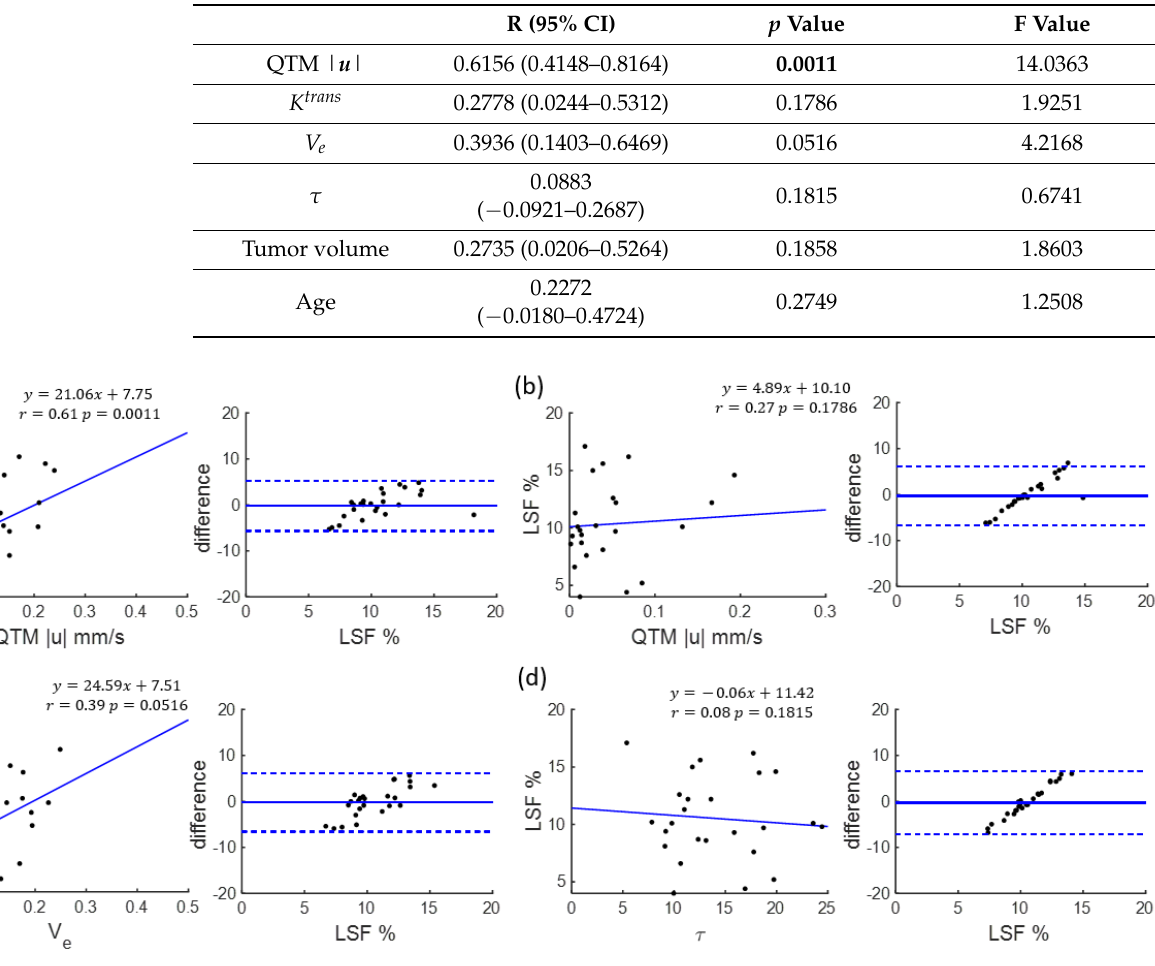
Figure 3. Spearman correlation and Bland – Altman plot of ( a ) QTM |𝒖| , ( b ) 𝐾 𝑡𝑟𝑎𝑛𝑠 ( c ), 𝑉 𝑒 , ( d ) 𝜏 with lung shunting fraction (LSF). Table 1. Spearman correlation with